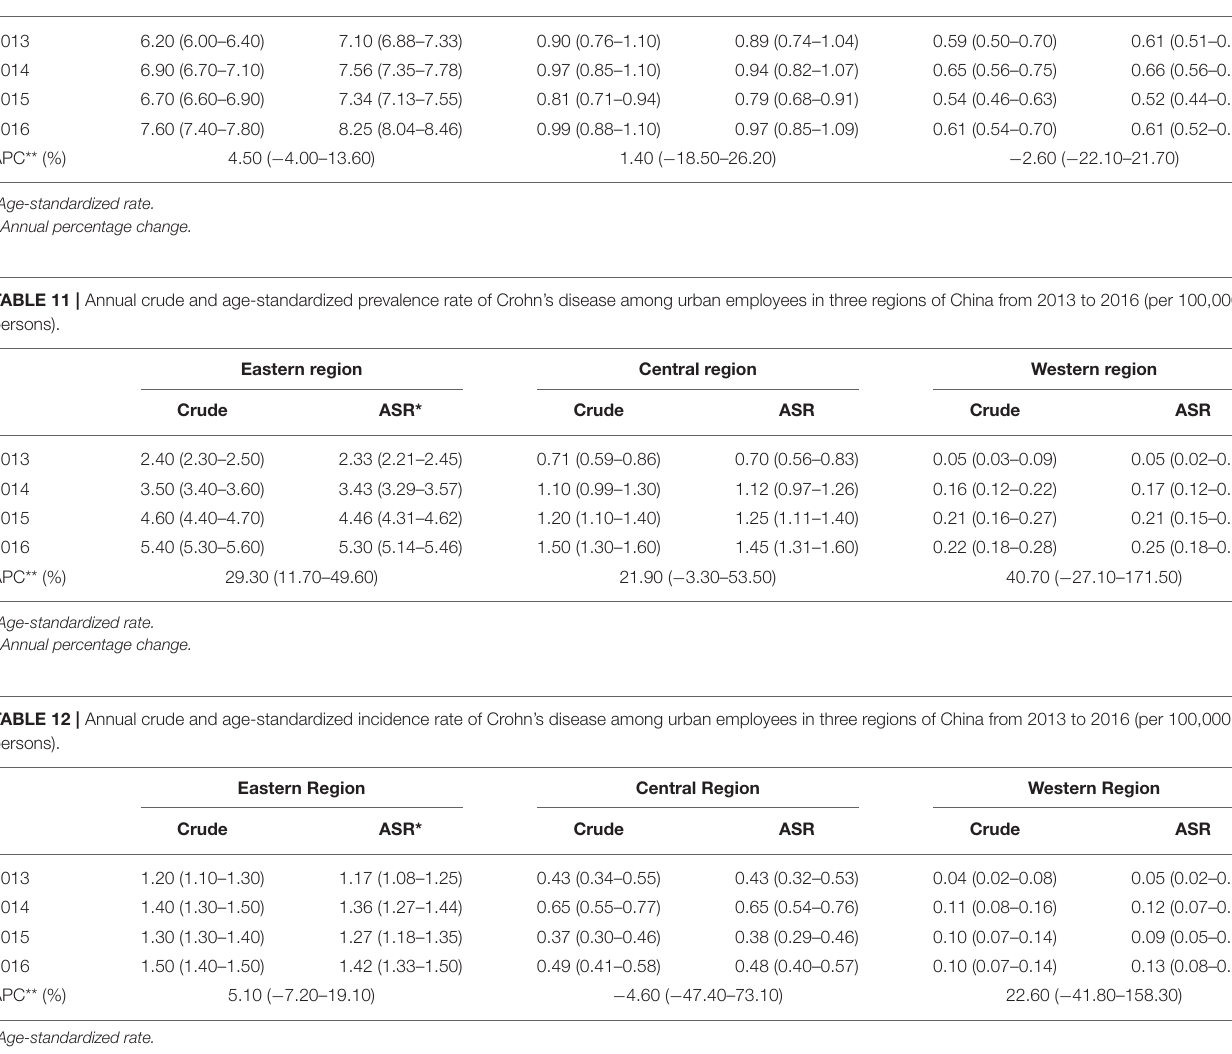
TABLE 10 | Annual crude and age-standardized incidence rate of ulcerative colitis among urban employees in three regions of China from 2013 to 2016 (per 100,000 persons). Eastern region Central region Western region Crude ASR* Crude